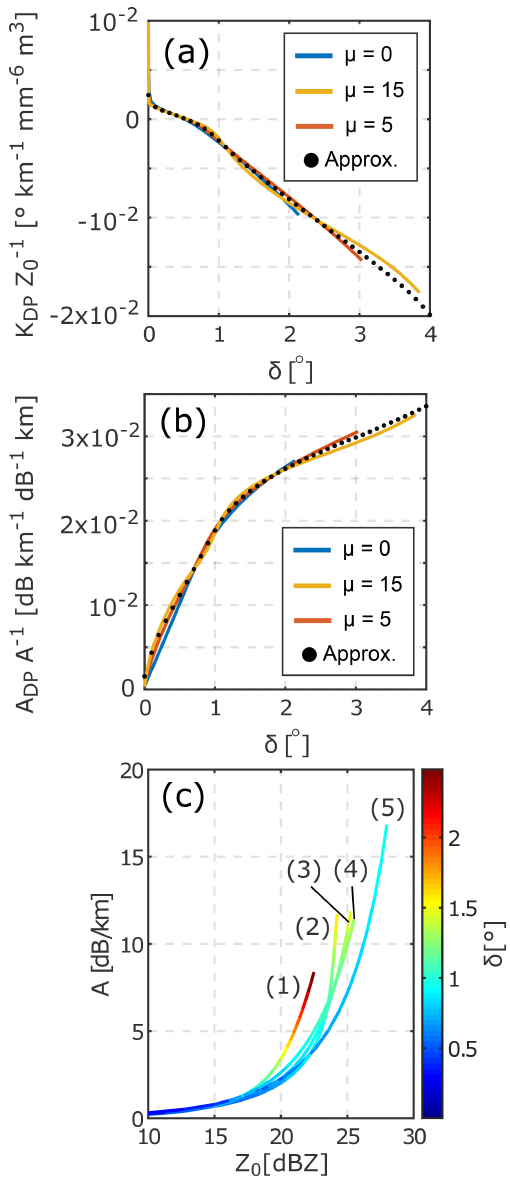
Figure 5. Relations between K DP , Z 0 , and δ (a) , A DP , A , and δ (b) , and A , Z 0 , and δ (c) at 94GHz. The solid lines show the calculations for different DSDs, and the black dots de- note the fitted approximations (Eqs. 1a and 2b). In panel (c) , the calculations are made for µ = 5 and N L = 2500mm − 1 m − 3 (1), µ = 15 and N L = 8000mm − 1 m − 3 (2), µ = 5 and N L = 8000mm − 1 m − 3 (3), µ = 0 and N L = 8000mm − 1 m − 3 (4), and µ = 5 and N L = 25000mm − 1 m − 3 (5). The rain rates are all smaller than 20mmh − 1 . All calculations are made for a 30 ◦ ele- vation angle and a temperature of 20 ◦ C. The units of Z 0 , A , K DP , and A DP in panels (a) and (b) are mm 6 m − 3 , dBkm − 1 , ◦ km − 1 , and dBkm − 1 ,